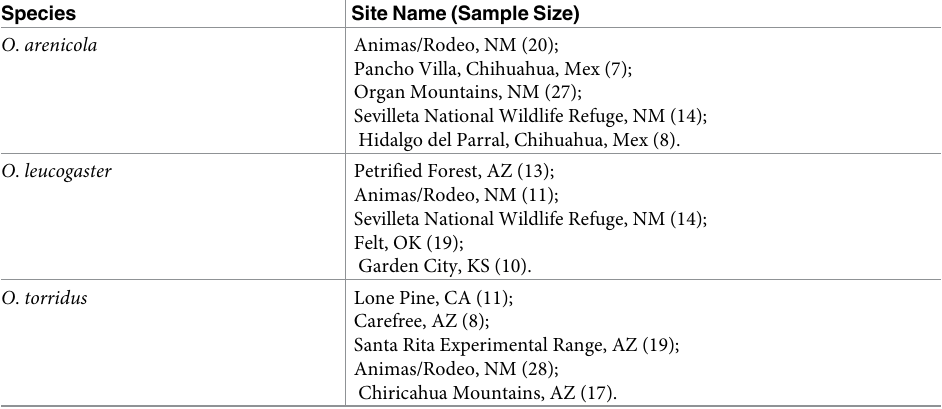
Table 2. Geographic location of grasshopper mouse ( Onychomys ) samples.